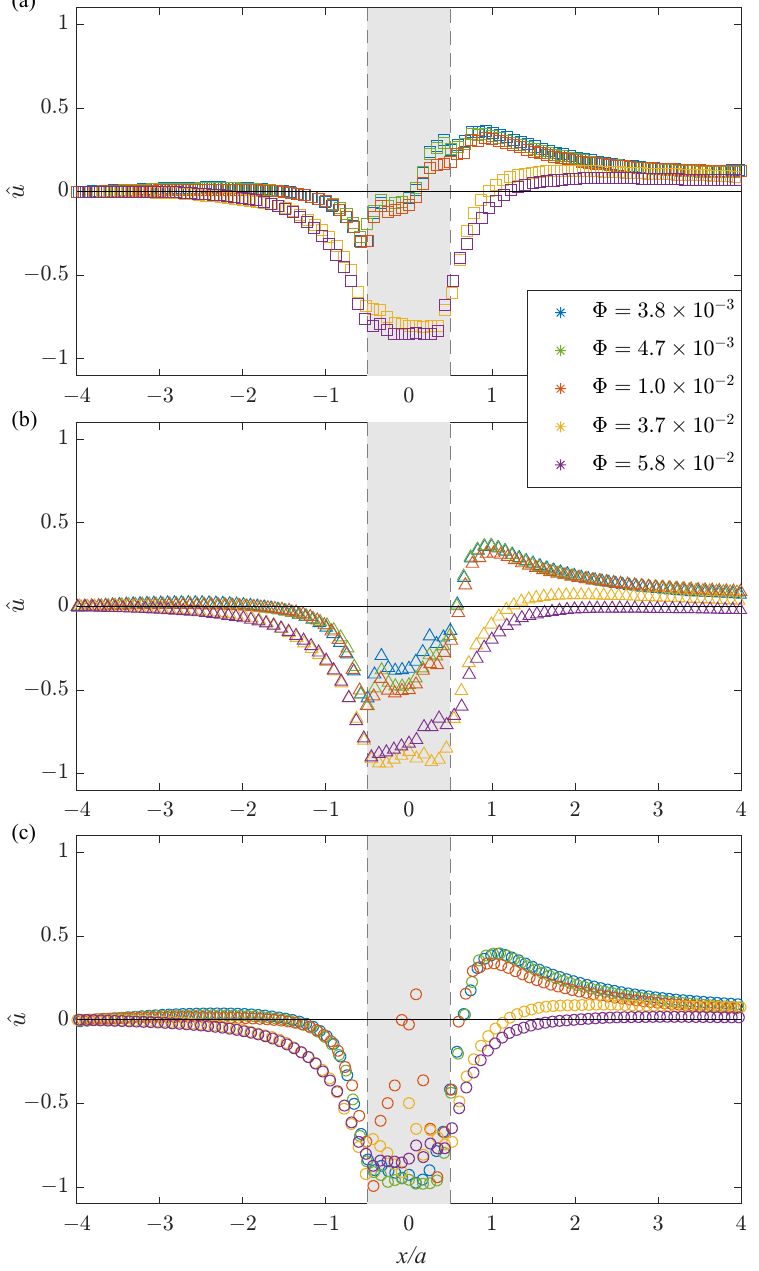
Figure 5. Profiles of the normalized longitudinal velocity ˆ u along the x -axis for obstacle heights H / G of ( a ) 0.35, ( b ) 0.6 and ( c ) 0.78 and liquid fractions of Φ = 3.8 × 10 − 3 (blue), 4.7 × 10 − 3 (green), 1.0 × 10 − 2 (red), 3.7 × 10 − 2 (yellow) and 5.8 × 10 − 2